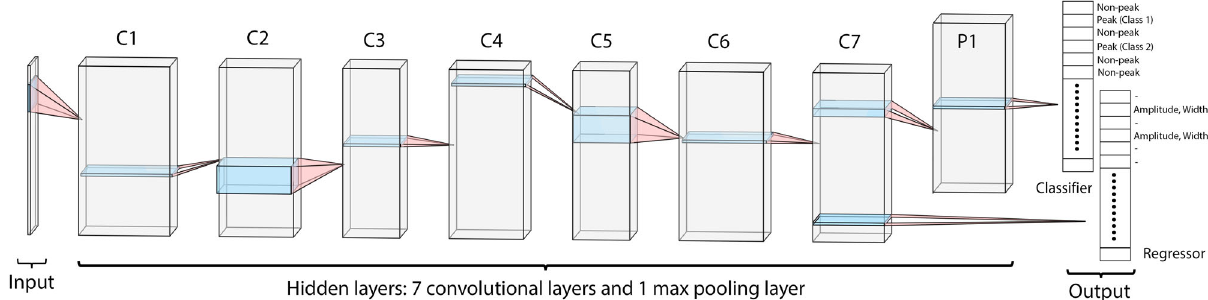
Fig. 2 Architecture of the deep neural network peak picker (DEEP Picker), which is composed of seven 1D convolutional layers with recti fi ed linear (ReLU) unit activation functions (C1 – C7), one max-pooling layer (P1), one convolutional layer with a SoftMax activation function to classify every data point, and one convolutional layer with linear activation function to predict the peak position at the sub-pixel resolution, peak amplitude, peak width, and the Lorentzian fraction of its peak shape. The input of DEEP Picker is an N × 1 tensor (column vector), where N is the number of data points of the 1D input spectrum. Hidden layers and output layers all have the same dimension N as input. The depths of the 8 hidden layers (from C1 to C7, P1) are 40, 20, 10, 20, 10, 30, 18, and 18. Their kernel sizes are 11, 1, 11, 1, 1, 11, 1, and 3 and they are 1 for both the classi fi er and regressor. As is common in machine learning, all kernels are applied N times in a sliding window fashion with each layer having multiple kernels (note that in the fi gure for each layer only a single kernel is indicated for a given position). The output classi fi er layer (top right) yields the prediction of whether a data point is a Class 2 peak, Class 1 peak, or Class 0 non-peak. The output regressor layer (bottom right) yields the predicted peak parameters for all peaks (Class 2